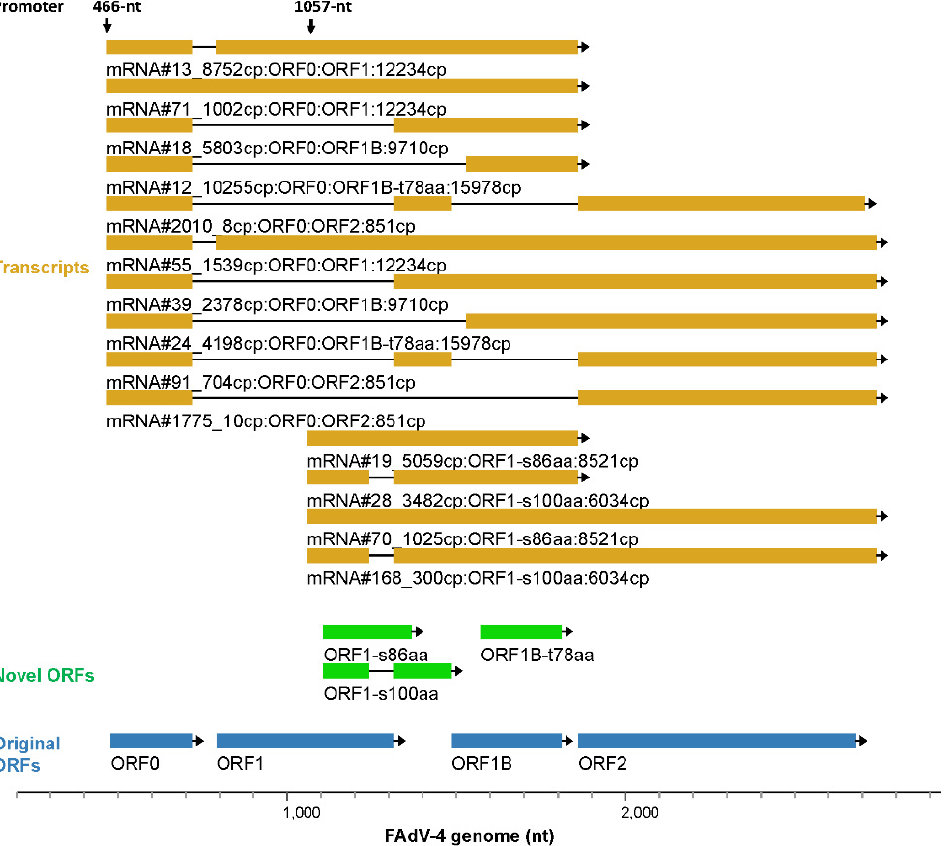
Figure 5. Key transcripts controlled by the forward 466-nt and 1057-nt promoters. A virus ORF was encoded by several transcripts, and the top 3 transcripts of an ORF in copy number were selected. Shown were the selected transcripts that initiated from the major transcription start sites (TSS). The sum of the copy numbers of all transcripts that encoded an ORF was calculated and defined as the copy number of the ORF, which was appended to the end of the ORF name. Original ORFs: the ORFs that had been annotated in previous publications. Novel ORFs: the ORFs that were newly found in this study.